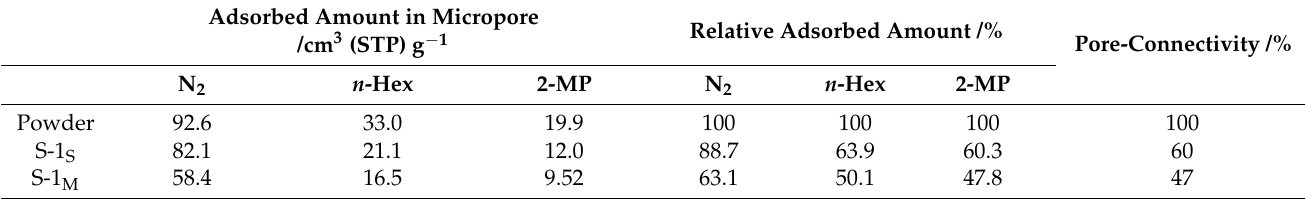
Table 2. Amounts adsorbed in the micropores of silicalite-1 powder and membranes. Adsorbed Amount in